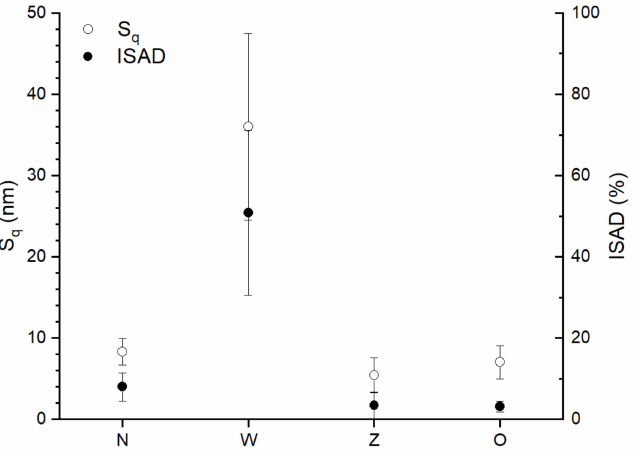
Figure 2. Surface roughness and development averaged over the samples (N: intact, W: etched, Z: resin, O: cleaned).